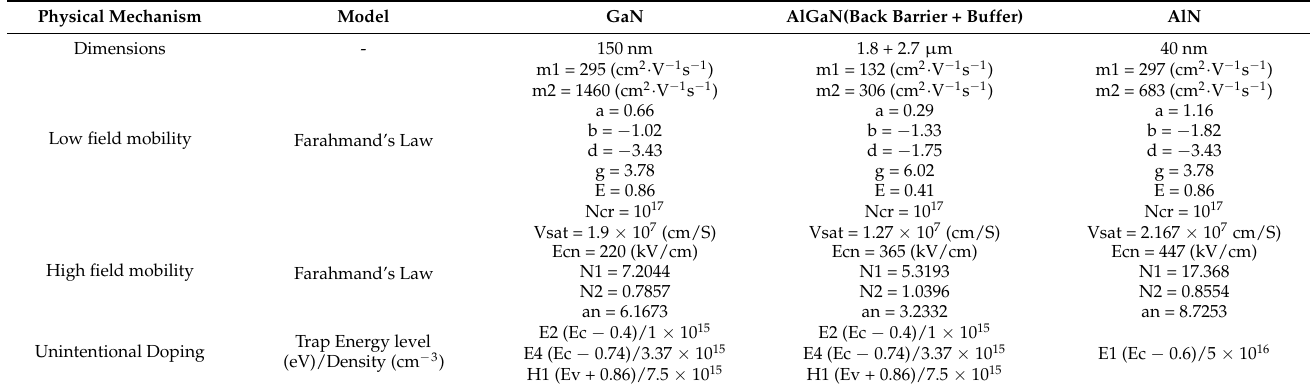
Table 1. Geometrical and model parameters of the device used in the